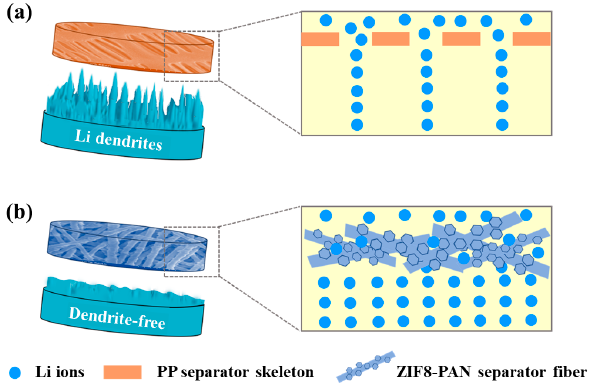
Figure 1. Schematic diagram of: ( a ) non-uniform deposition of Li ions after passing through PP separator; ( b ) uniform deposition of Li ions after redistribution through the obtained ZIF8-PAN separator.